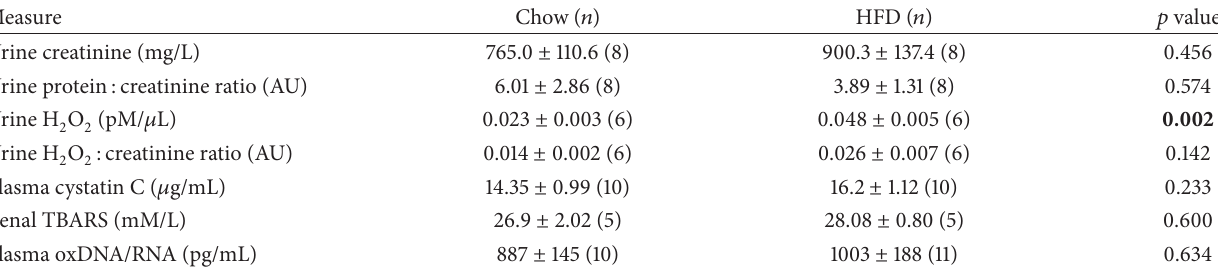
Table 2: Plasma and urinary markers of renal functionand damage.